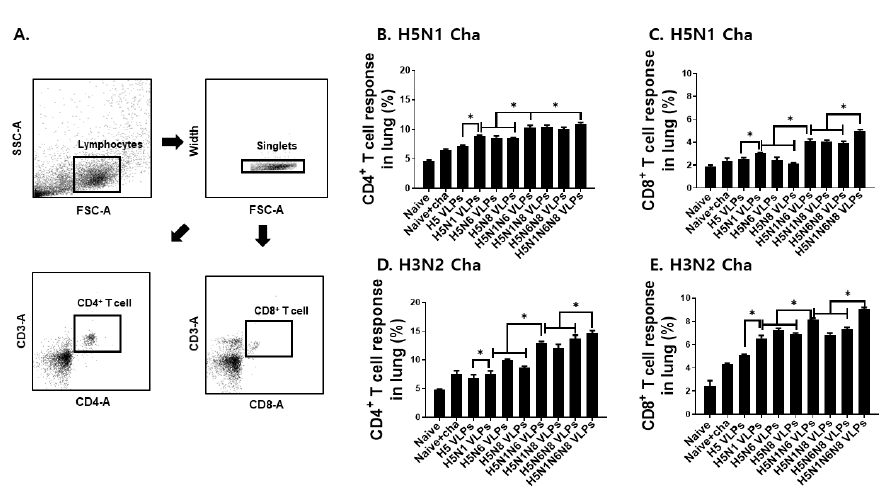
Figure 4. CD4+ T cell and CD8+ T cell immune responses in the lungs upon challenge infection with H5N1 or H3N2 influenza viruses. BALB/c mice were intramuscularly immunized twice with the VLPs. Lung samples were collected at 4 days post-challenge infections with H5N1 or H3N2 influenza viruses. Lung cells were gated using the strategy depicted above ( A ) to determine CD4+ T cell ( B , D ) and CD8+ T cell ( C , E ) responses. Immune cells collected from the lungs were stimulated with inactivated viruses (0.5 μ g /mL) from H5N1 or H3N2. The lung cells were stained with anti-CD3, CD4, CD8 and the populations were determined by flow cytometry analysis. All data are expressed as mean ± SD (* p < 0.05).